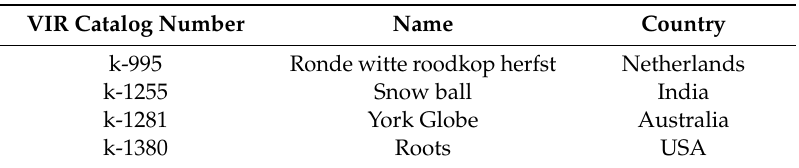
Table 5. Donor cultivars of